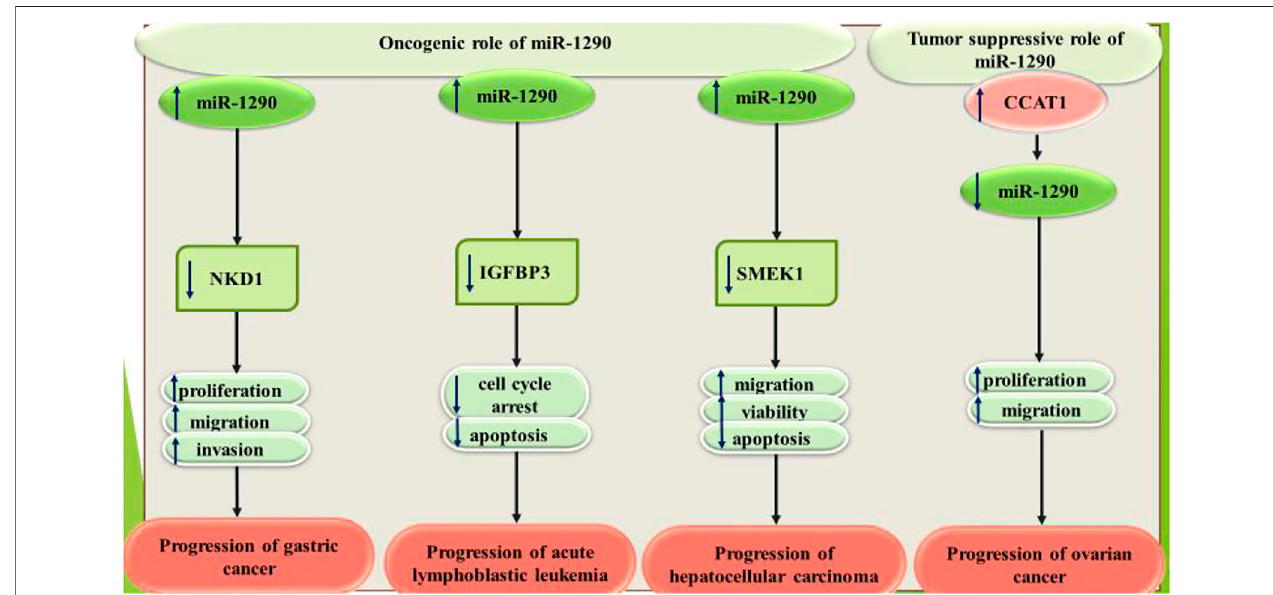
FIGURE 3 | miR-1290 has oncogenic roles in gastric cancer, acute lymphoblastic leukemia and hepatocellular carcinoma, while it has tumor suppressive roles in ovarian cancer.